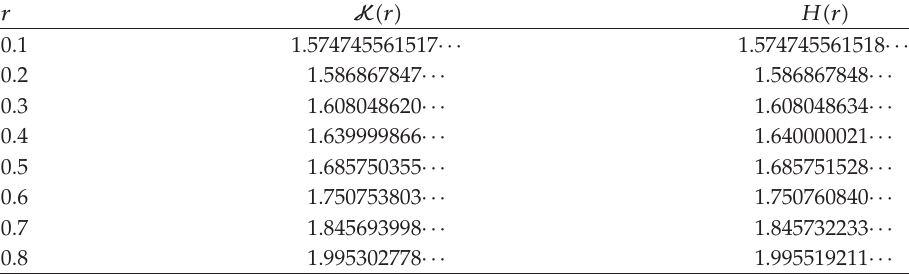
Table 1: Comparison of K (cid:2) r (cid:3) with H (cid:2) r (cid:3) for some r ∈ (cid:2) 0 , 1 (cid:3)